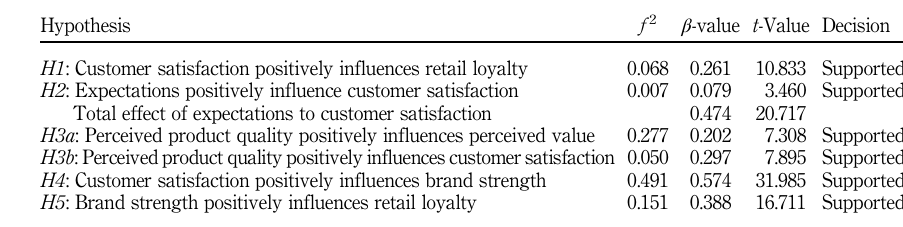
Table V. Summary of the hypotheses and